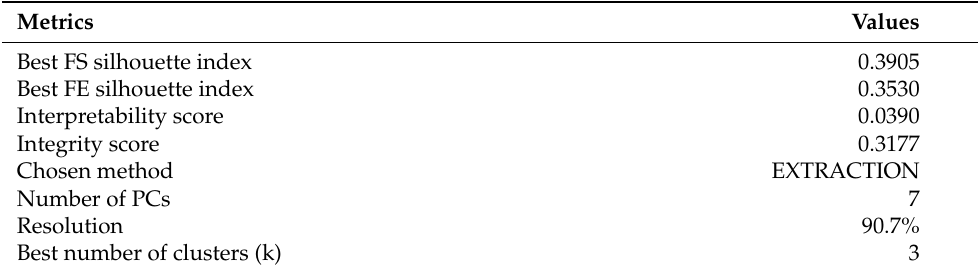
Table 6. Algorithm results using interpretability-oriented = 0.1, integrity-oriented = 0.9 and target-